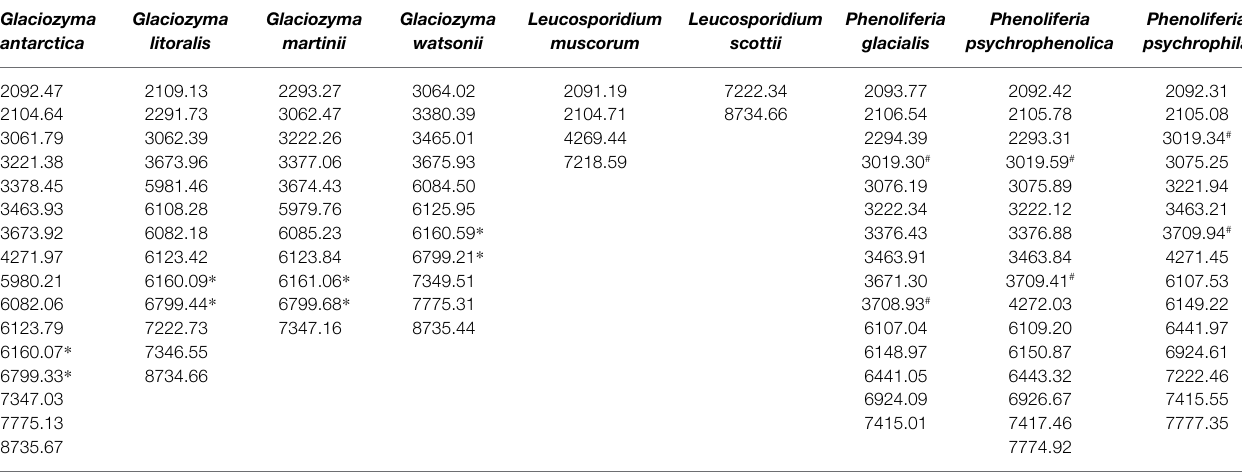
TABLE 3 | Peptide markers of Glaciozyma , Leucosporidium , and Phenoliferia species in